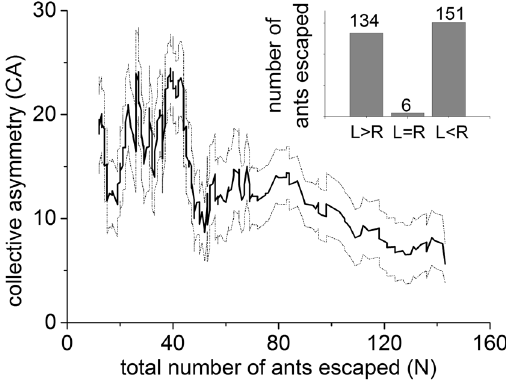
Fig. 2. Moving average of the collective asymmetry ( CA ) vs. the total number of escaped ants ( N ). The two dashed lines above and below the curve are the SD s (the standard error of the mean) of the moving average. This curve displays a high profile when the number of ants is small as well as a decrease of CA to a low profile when the number of ants is large. The inset shows, within the 291 individual experiments, that the number of experiments in which L w R , L v R and L ~ R is 151, 134 and 6, respectively. L and R denotes the total number of ants escaping left and right, respectively. This indicates that there are no hidden biased environmental factors affecting the direction of ant